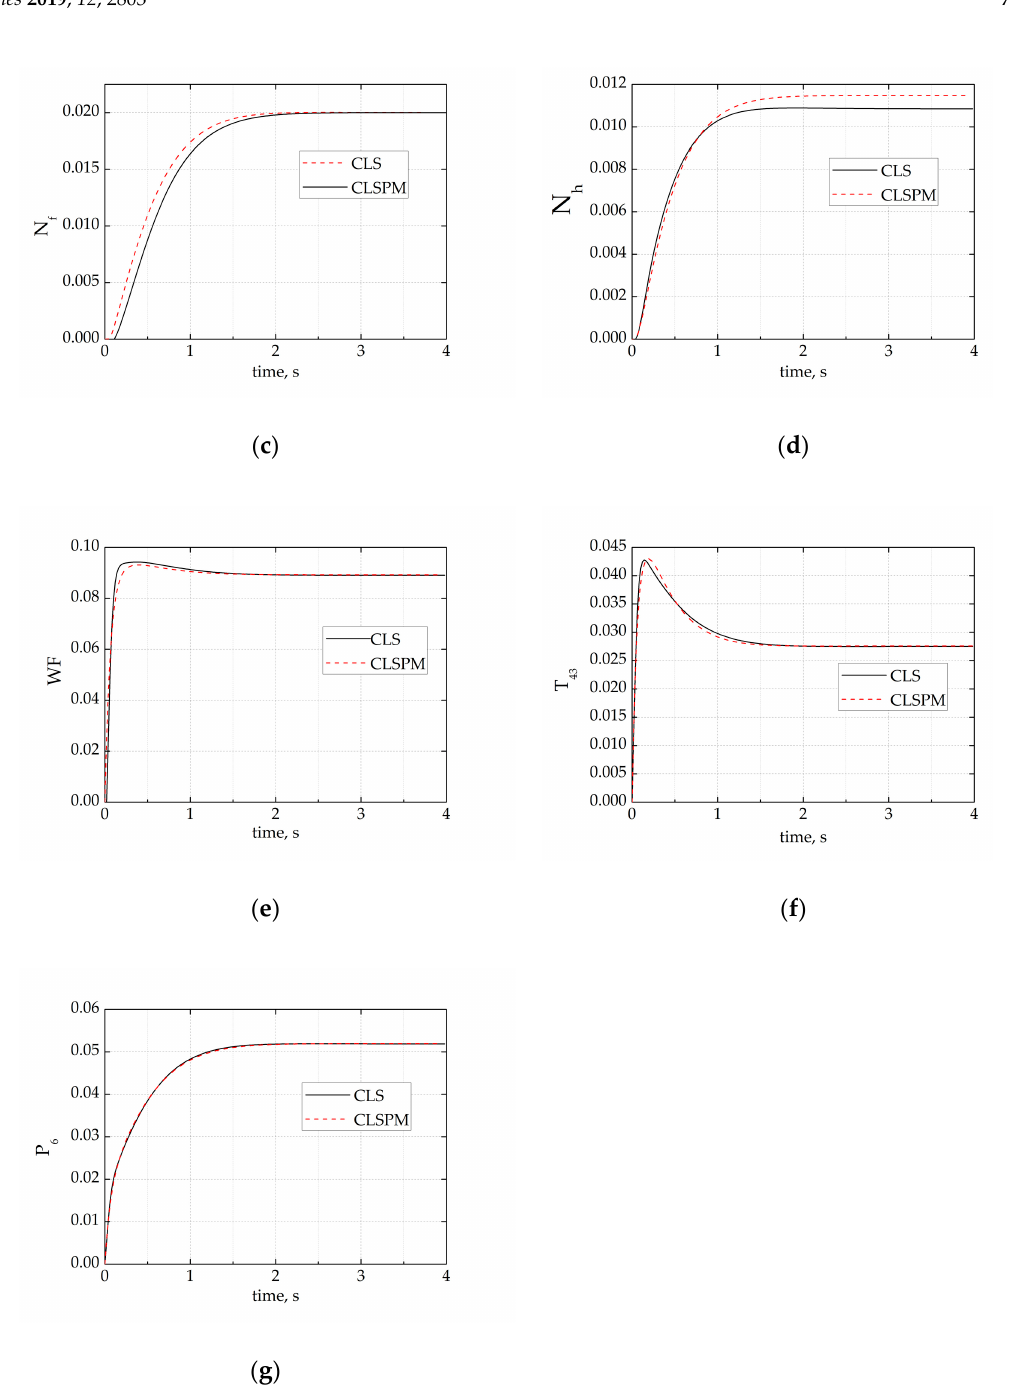
Figure 3. Comparisons of simulations with parameter perturbing under 2% step reference. ( a ) The time history of the rate of fan speed; ( b ) the time history of the rate of the high-pressure rotor speed; ( c ) the time history of fan speed; ( d ) the time history of high-pressure rotor speed; ( e ) the time history of the rate of fuel flow; ( f ) the time history of the rate of the high-pressure turbine outlet temperature and ( g ) the time history of the low-pressure compressor outlet pressure.